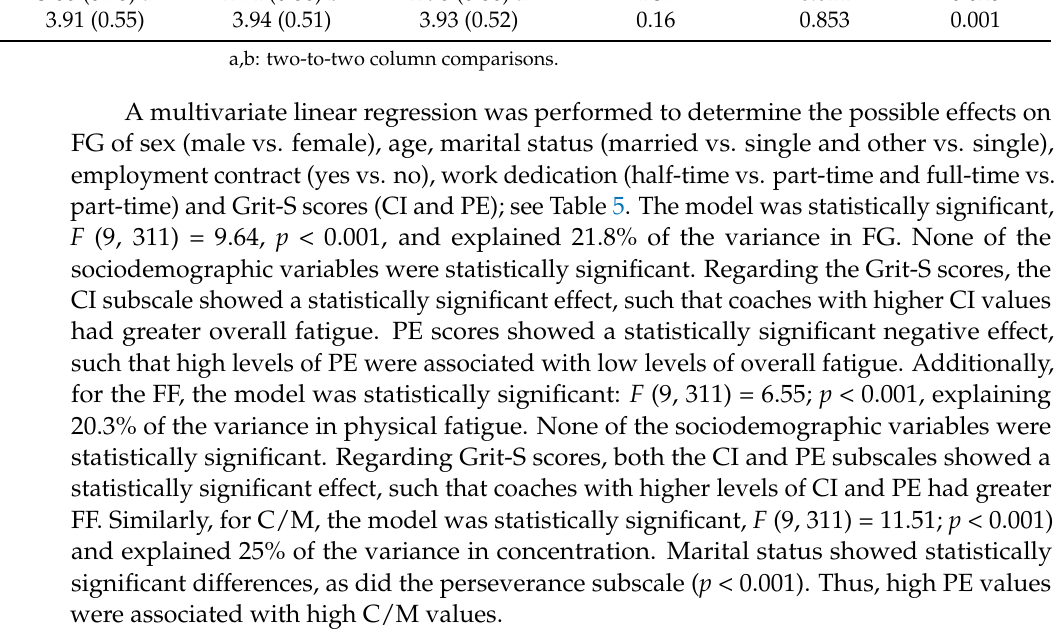
Table 4. ANOVA results and means of MFI and Grit-S scores relative to training category. Category, Mean (SD) ANOVA Child